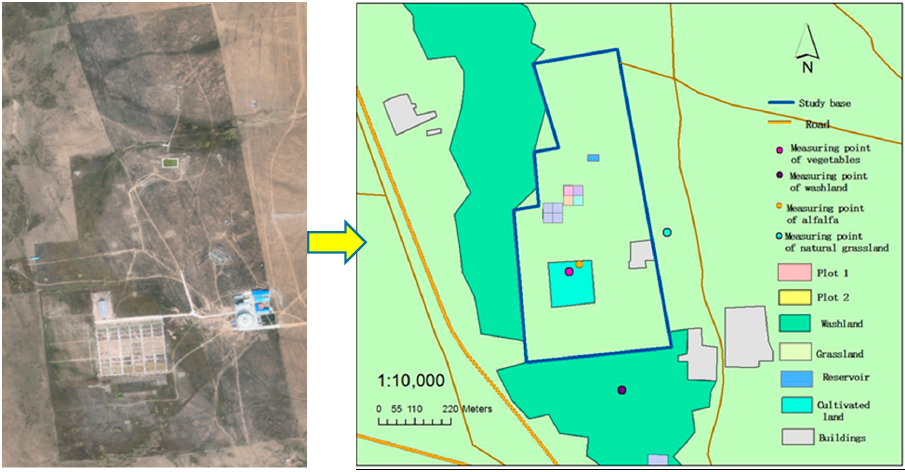
Figure 1. Distribution of land cover types in study area.